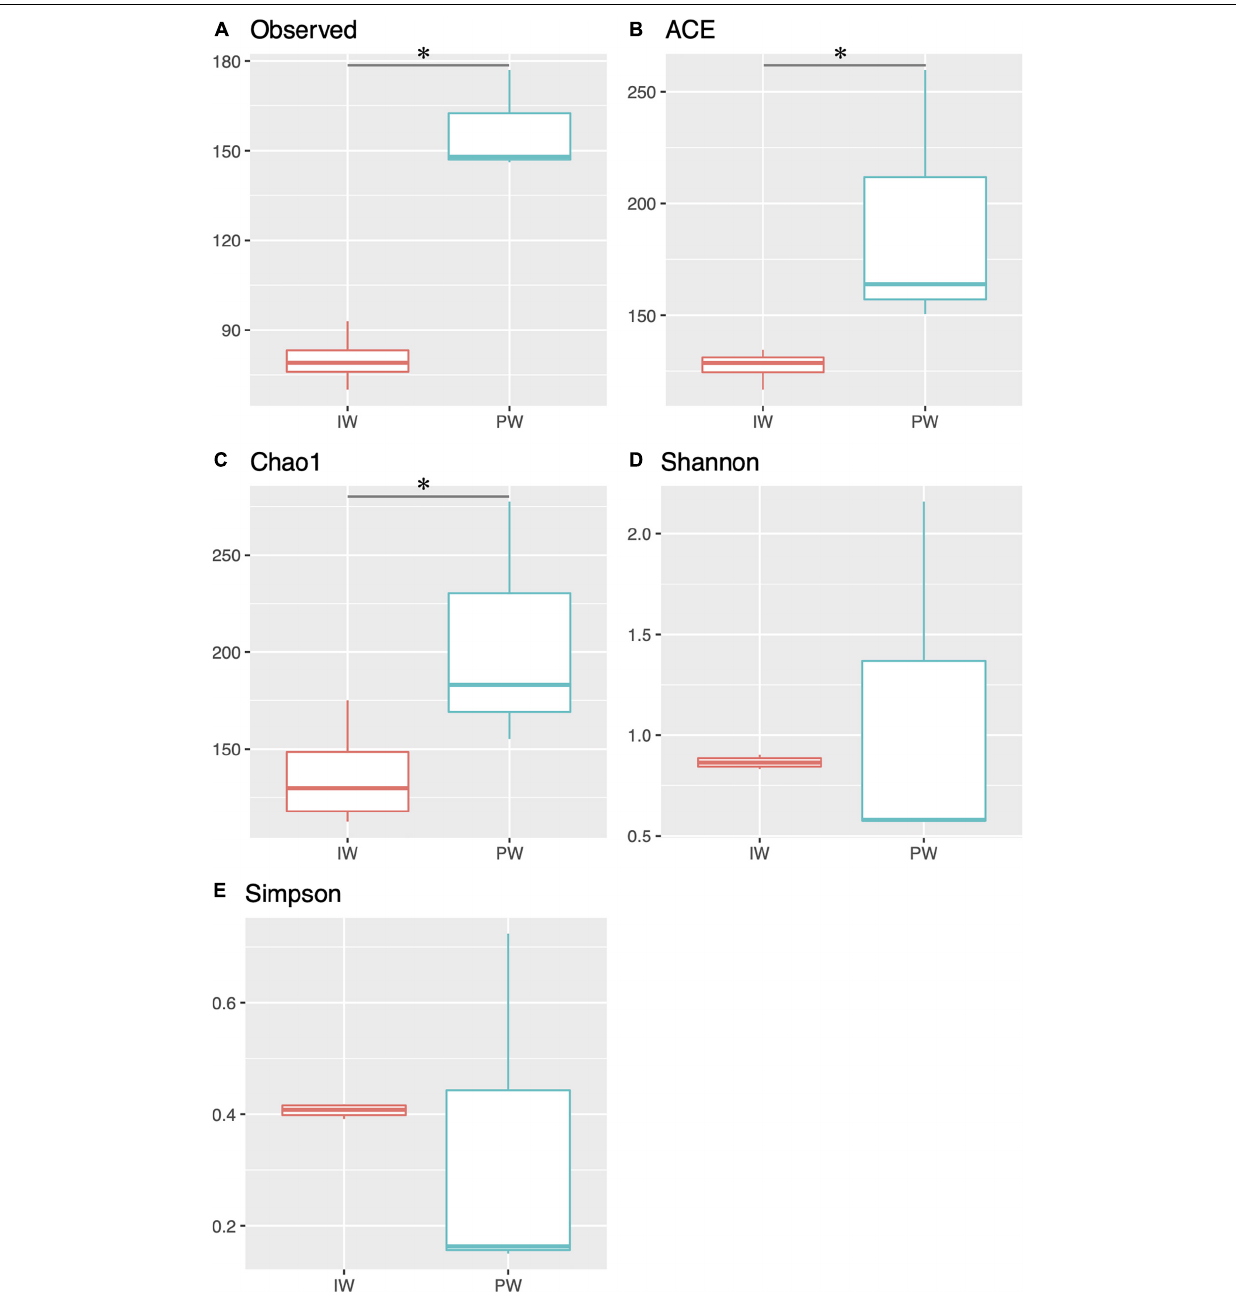
FIGURE 1 | Alpha diversity analysis. Box plot comparing richness and diversity indices of the injection water (IW) and produced water (PW). (A) Observed OTUs. (B) Ace index. (C) Chao1 index. (D) Shannon Index. (E) Simpson Index. Asterix denotes statistical significance in the compared groups ( p <